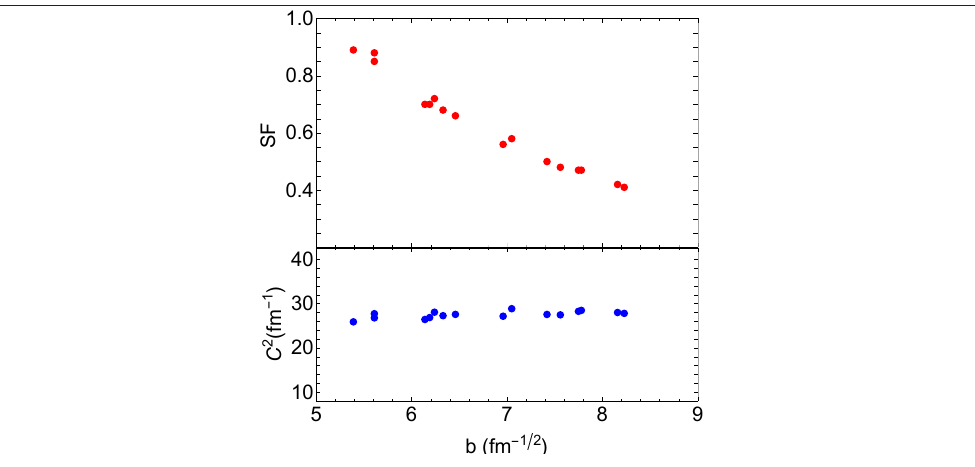
Figure 2. Spectroscopic factors (upper panel, red circles) and ANC values (lower panel, blue cir- cles)extracted for the ground state of 27 Mg versus the value of the SPANC b. The calculations have been done using the optical potential P1 of [8]. In this calculations the r 0 parameter has been varied between 1.1 and 1.4 fm and a 0 between 0.5 and 0.7 fm.